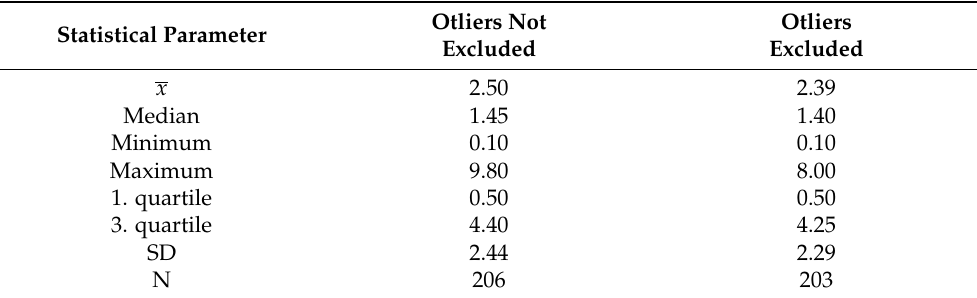
Figure 10. Scatter plot for 137 Cs massic activities vs. organic matter mass fractions. Extreme values for organic matter are excluded. Table 2. Basic statistical parameters of 137 Cs massic activities in sediment; for samples with activities above minimum detectable activity; activities are expressed in Bq kg − 1 ; x , mean value; SD, standard deviation; N, number of